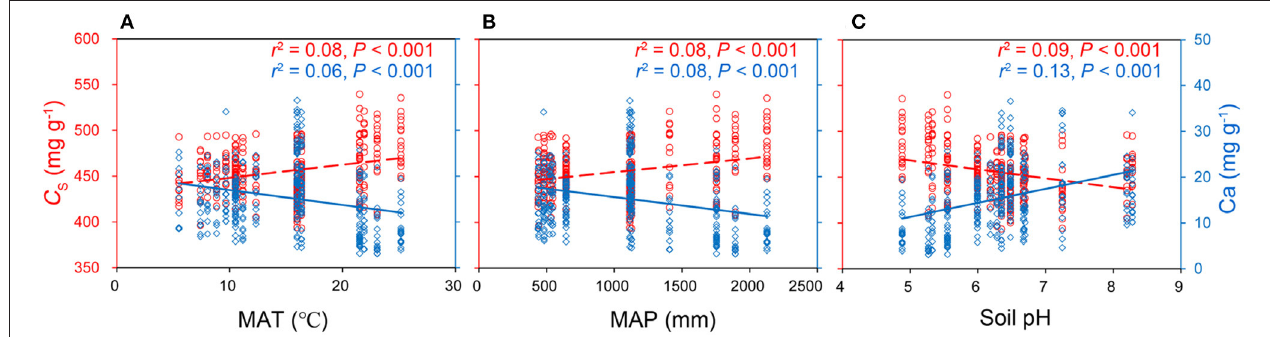
FIGURE 2 | The double y-axis graphs explaining the relationships between leaf protein-free carbon (C S ), calcium (Ca) concentrations (mg g − 1 ), and mean annual temperature (MAT) (A) , mean annual precipitation (MAP) (B) , and soil pH (C) at species scale ( n : 335 species by sites). The red left y-axis indicated leaf C S , the blue right y-axis indicated leaf Ca. Equations of linear relationships: C S = 1.42MAT + 434 ( r 2 = 0.08, P < 0.001); Ca = − 0.33MAT + 20.2 ( r 2 = 0.06, P < 0.001);C S = 0.015MAP + 440 ( r 2 = 0.08, P < 0.001); Ca = − 3.69 × 10 − 3 MAP + 19.2 ( r 2 = 0.08, P < 0.001);C S = − 9.6pH + 516 ( r 2 = 0.09, P < 0.001); Ca = 3.06pH – 3.98 ( r 2 = 0.13, P <